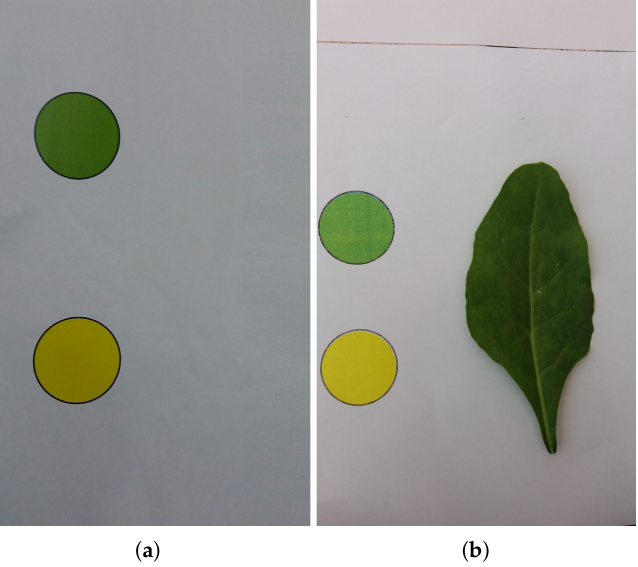
Figure 1. ( a ) Slate being used to capture the plant leaf image, ( b ) a sample spinach leaf image captured with a smartphone camera using the slate in ( a ).